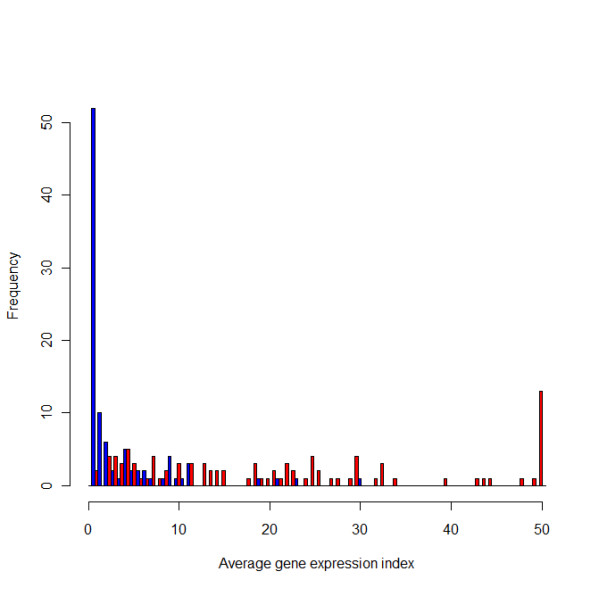
Average gene expression indices for σB-dependent genes. The histogram shows the average GEI of σB-dependent genes in 10403S (red) and the ΔsigB (blue) strains. GEIs were grouped in intervals of 0.7, i.e., the first bar represents genes with GEIs between 0 and 0.7; the second bar represents GEIs between > 0.7 and ≤ 1.4, etc. Genes with average GEI ≥ 50 were grouped together.